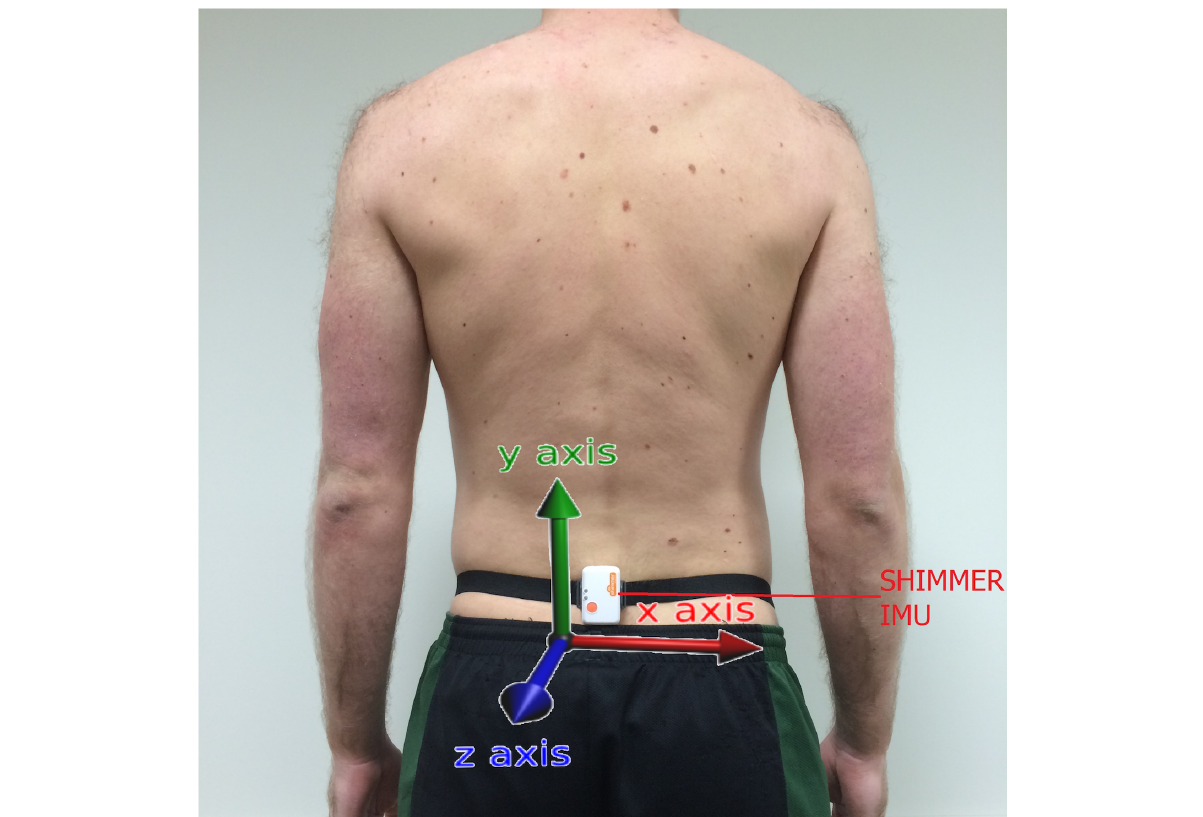
Figure 3. Inertial measurement unit (IMU) position: the spinous process of the 5th lumbar